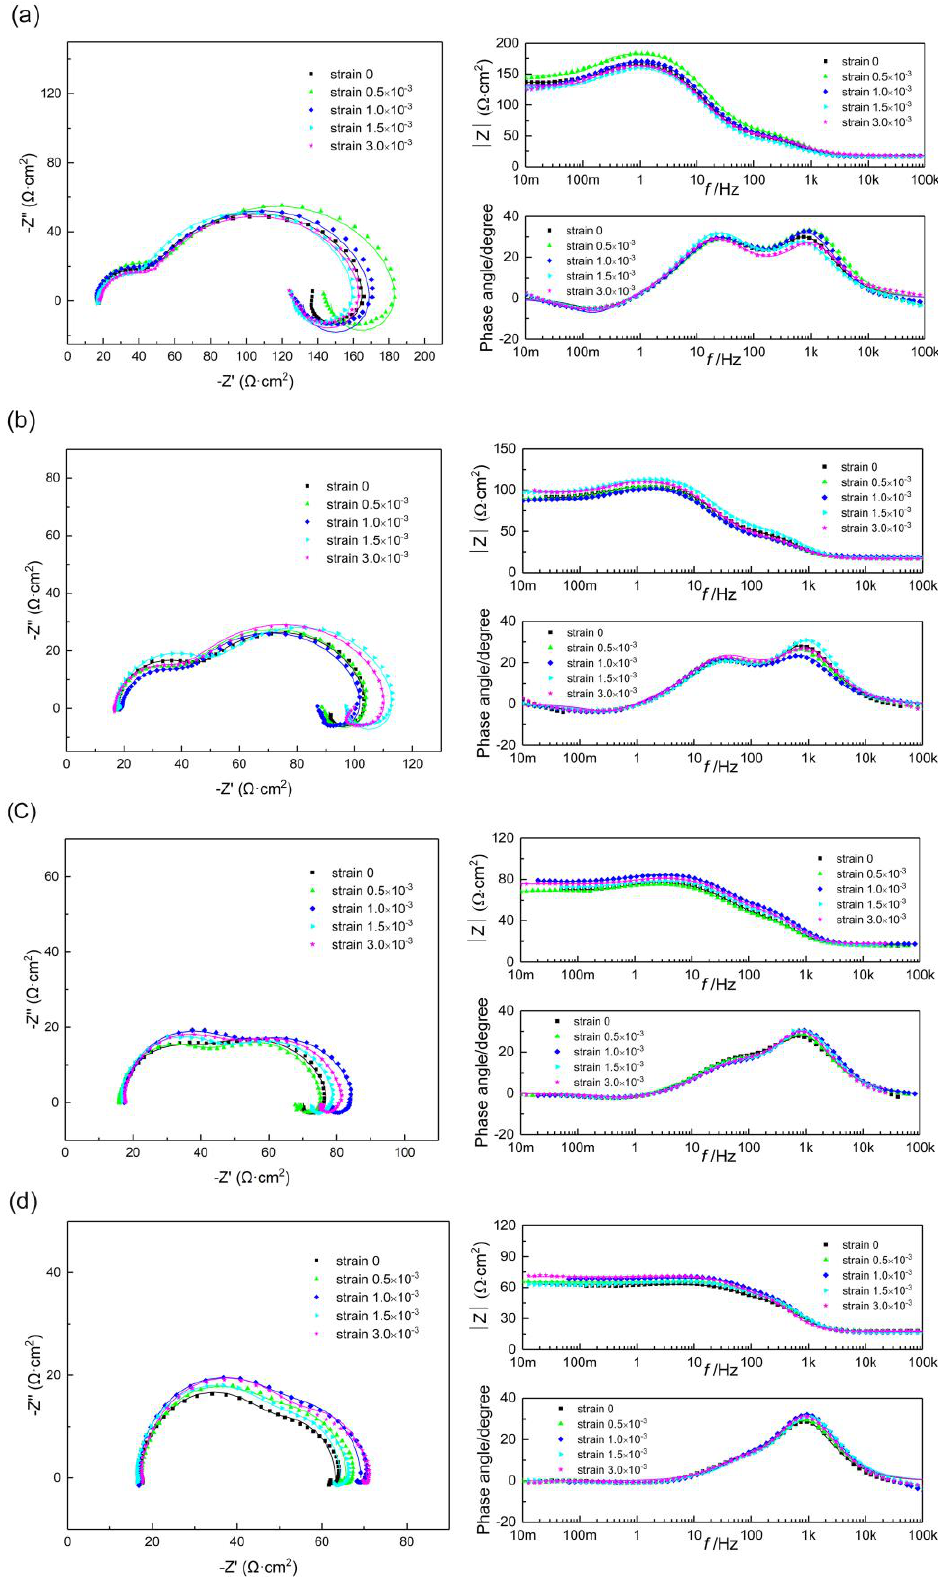
Figure 7. Nyquist and Bode plots of X80 steel sample in NS4 solution with strain under different applied DC: ( a ) 0.25 mA/cm 2 , ( b ) 0.5 mA/cm 2 , ( c ) 1 mA/cm 2 , ( d ) 2 mA/cm 2 .